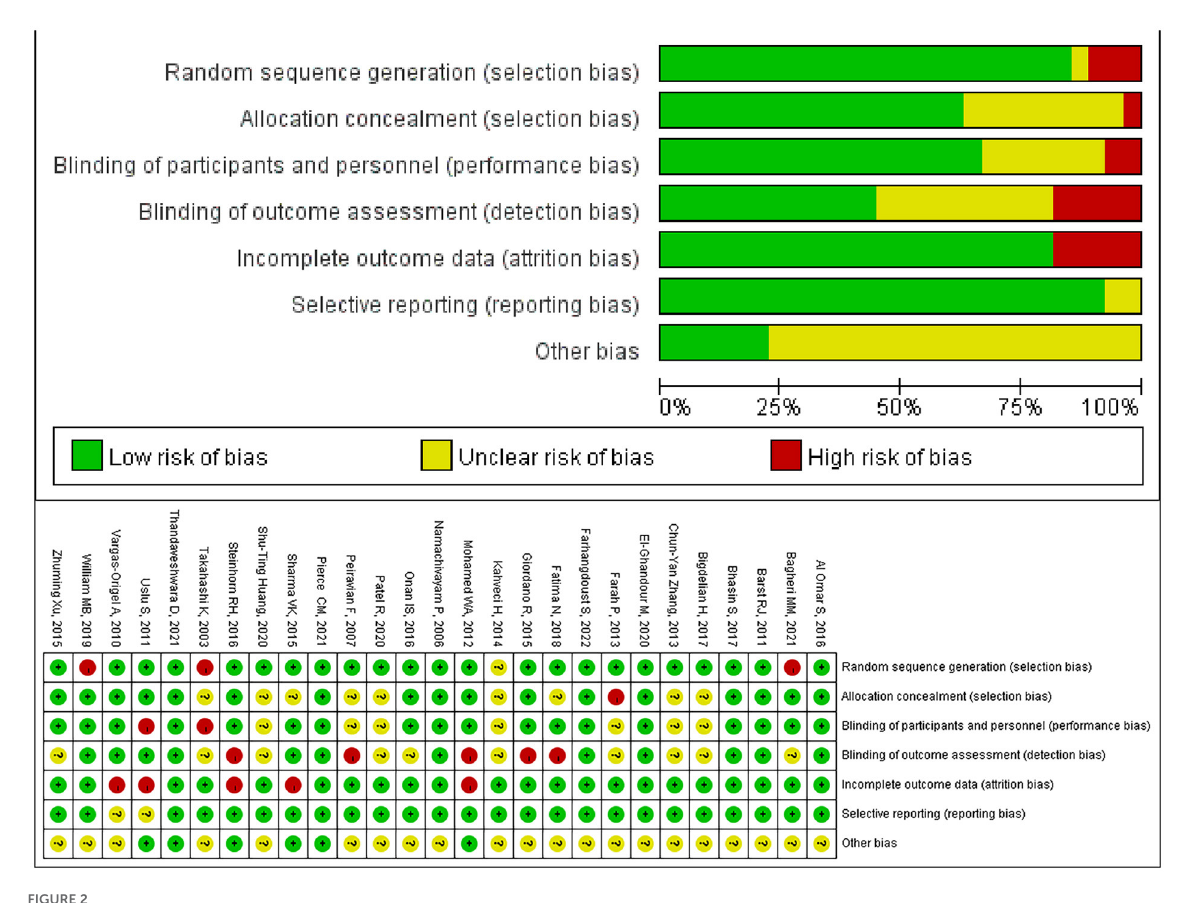
FIGURE2 Risk of